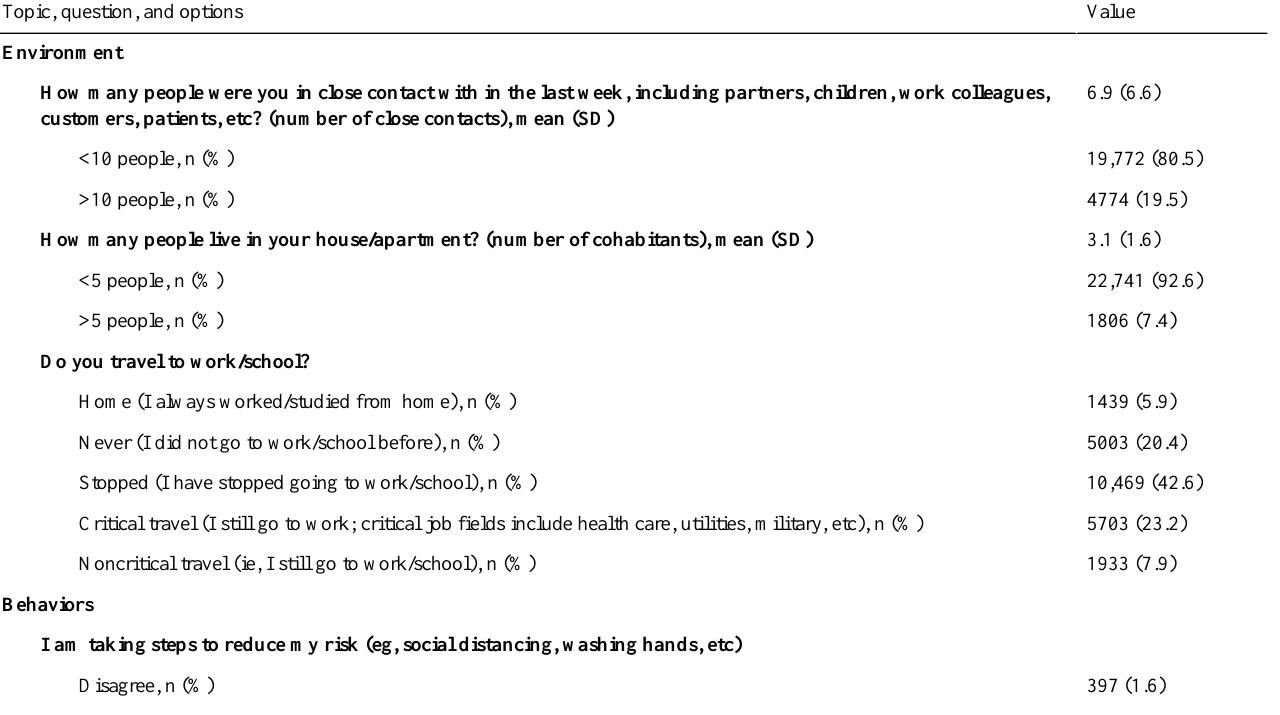
Table 1. Questionnaire on the environmental and behavioral factors that affect people’s perceptions of the risk of contracting COVID-19. ValueTopic, question, and